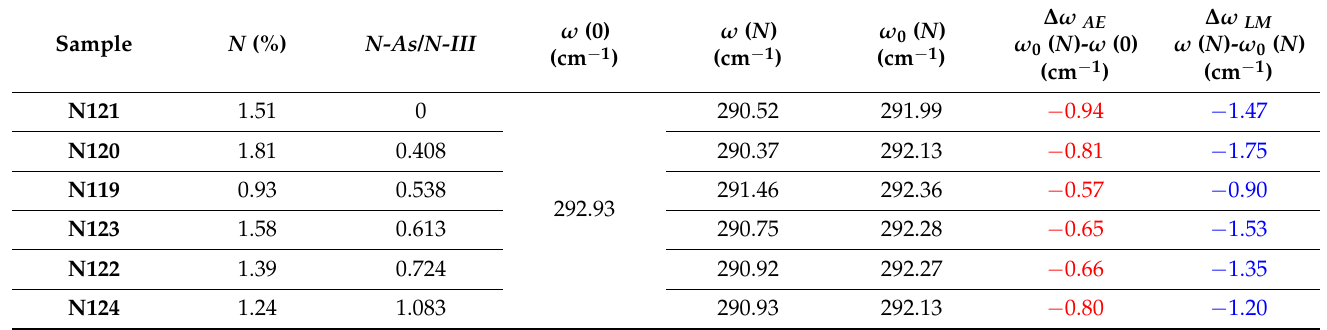
Table 3. The ratio of N-As / N-III , GaAs-like LO frequencies of: GaAs epilayer ω ( 0 ) , strained GaAsN epilayer ω ( N ) , bulk GaAsN ω 0 ( N ) and Raman frequency shift of GaAs-like LO phonons caused by the lattice mismatch ω LM and alloying effect ω AE determined for all investigated GaAsN/GaAs heterostructures. Red and blue colours represent the calculated values depicted in Figures 7a and 7b, respectively.